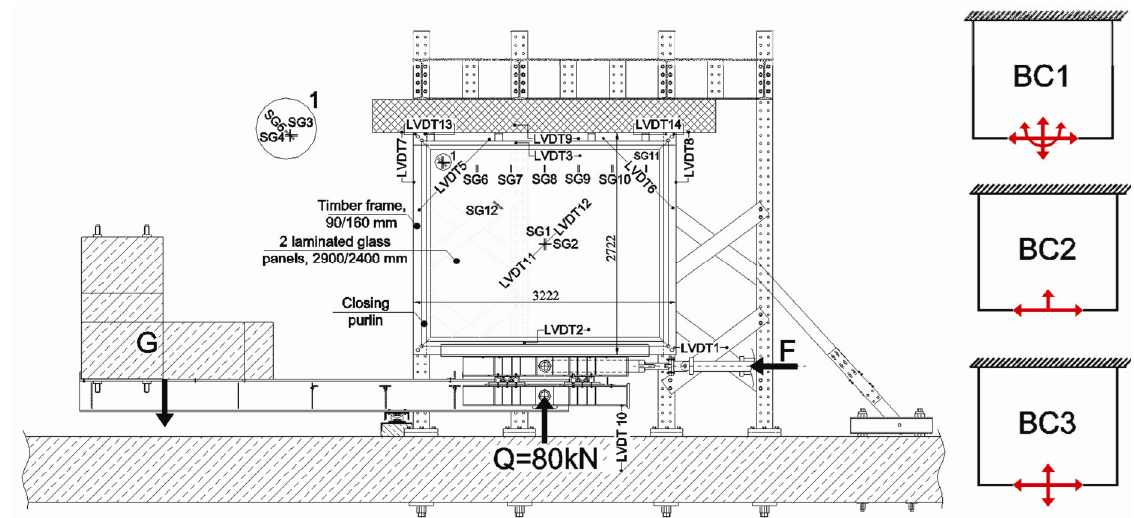
Fig. 2. Quasi-static racking-test facility for shear testing of panels, instrumentation of tested specimens (left) and scheme of boundary conditions